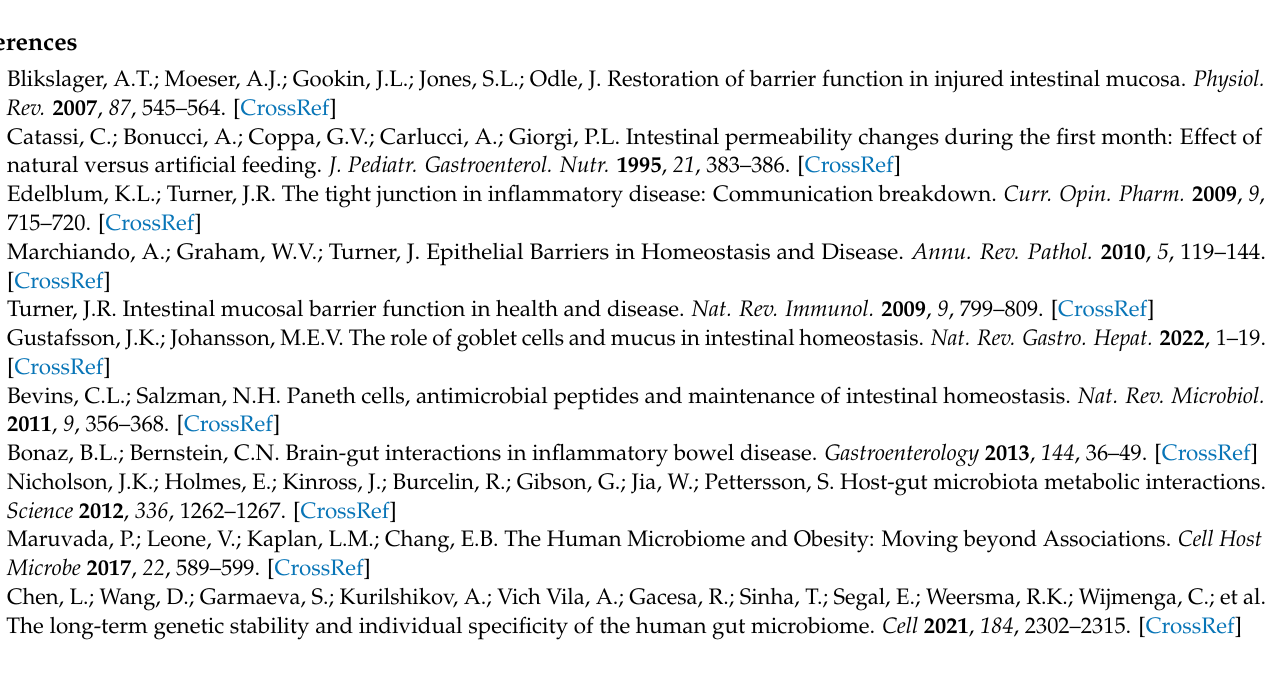
Table S1: Primer sequences used in the qRT-PCR